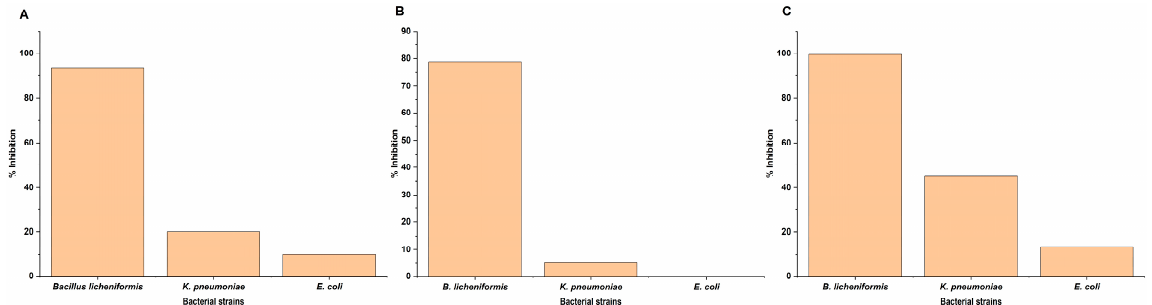
Figure 6. Broth assay indicating differential resistance/susceptibility of bacteria to the AgNP-treated fabric. ( A ) Bacterial growth inhibition by measuring optical density. ( B ) FDA bioassay. ( C ) Spread plate method.